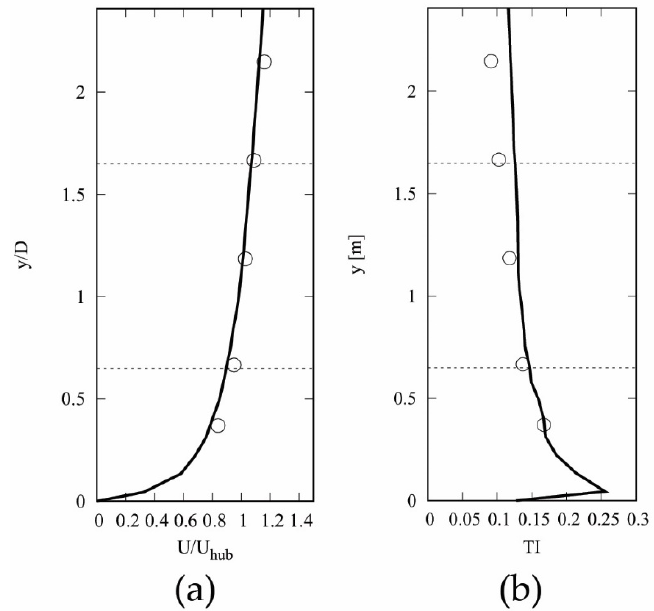
Figure 3. Ten-minute time-averaged ( a ) velocity profile and ( b ) turbulence intensity; ( ◦ ) met-tower measurements and ( – ) precursor simulation.